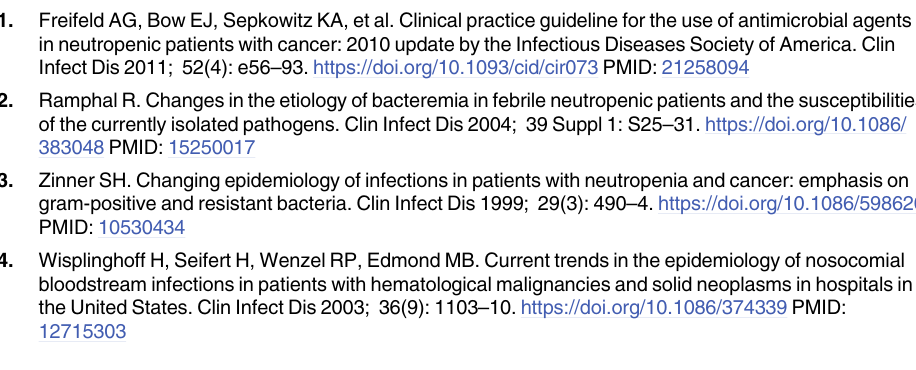
S3 Table. Clinical characteristics of the study subjects. S4 Table. List of organisms identified in the no template